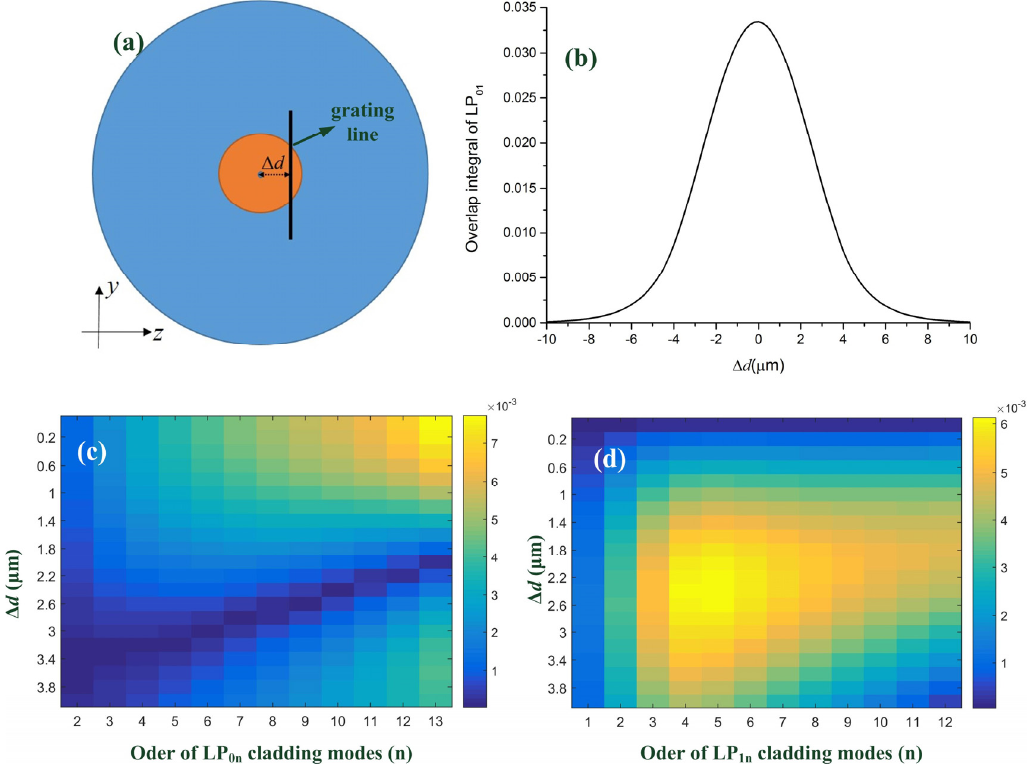
Figure 5. ( a ) Schematic of a cross-section of LBL-FBG. ( b ) Overlap integral of LP 01 versus offset distance ( Δ d ). ( c ) Overlap integral of LP 0n cladding modes versus offset distance ( Δ d ). ( d ) Overlap integral of LP 0n cladding modes versus offset distance ( ∆ d ). ( d ) Overlap integral of LP 1n cladding modes versus offset integral of LP 1n cladding modes versus offset distance ( Δ d ). distance ( ∆ d